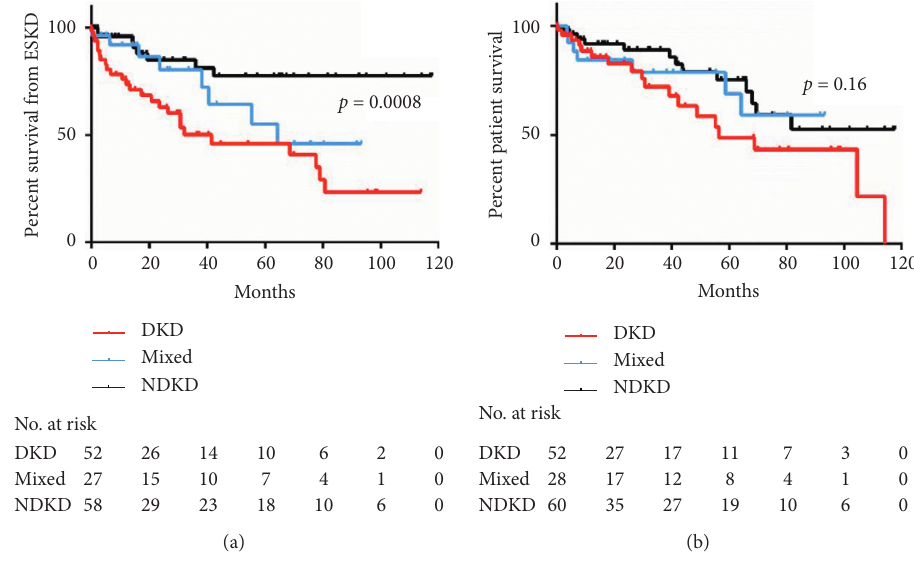
Figure 3: Kaplan–Meier curves for time to end-stage kidney disease (ESKD) (a) and time to death